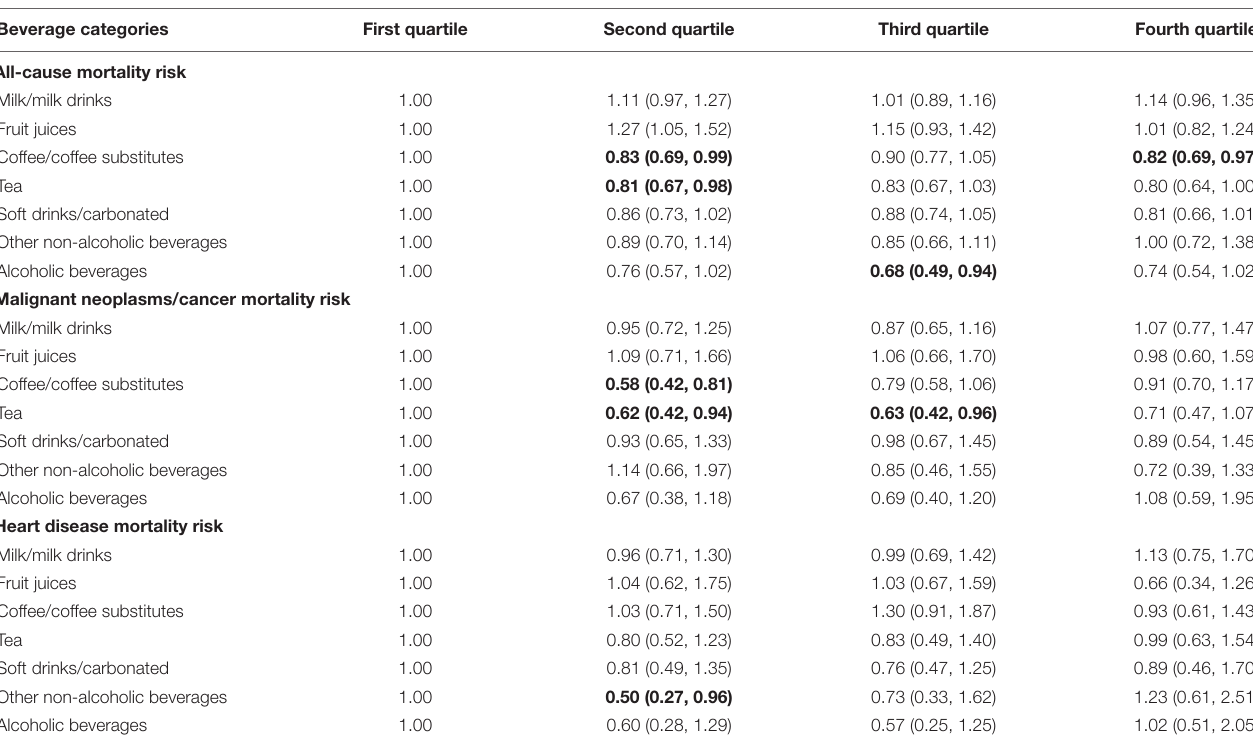
TABLE 5 | Associations of different beverage water intake with mortality risks due to all causes, malignant neoplasms/cancer and heart disease in the NHANESs 1999–2014